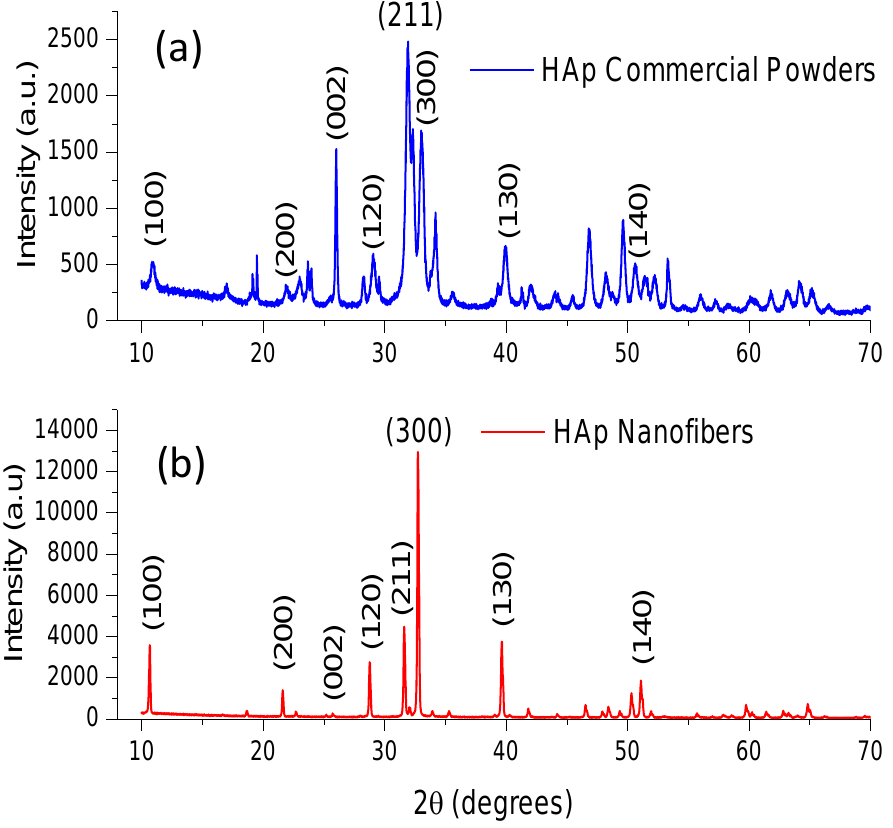
Figure 1. Typical XRD diffractograms of ( a ) commercial HAp powders and ( b ) HAp nanofibers. Notice the preferential crystalline orientation in the [001] direction. Indexing is indicated in both cases.